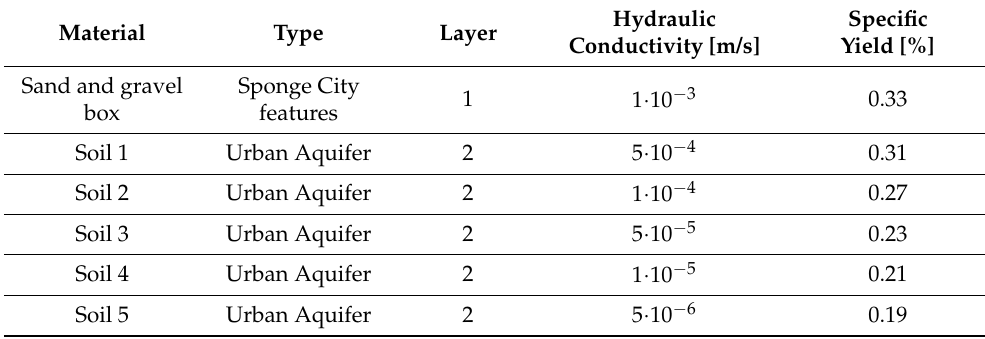
Table 1. Hydraulic conductivity and specific yield of the materials used for MODFLOW models. Simulations are repeated five times, varying the soil properties of the underlying urban aquifer.